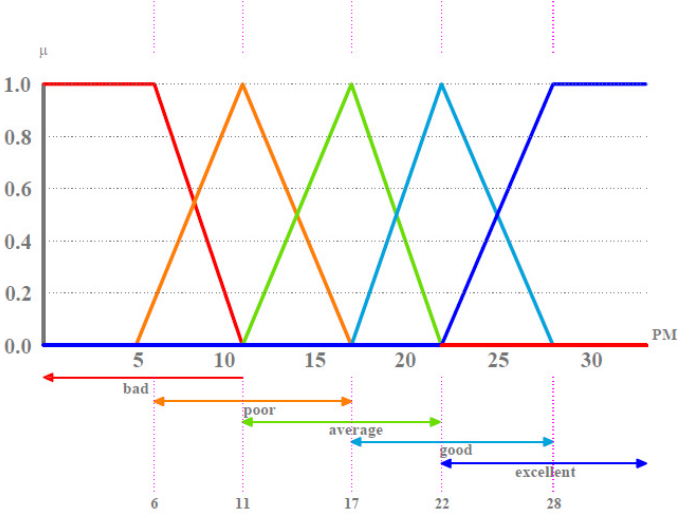
Figure 11. Membership functions of the condition scale for Preventive Maintenance (PM) Cycle.